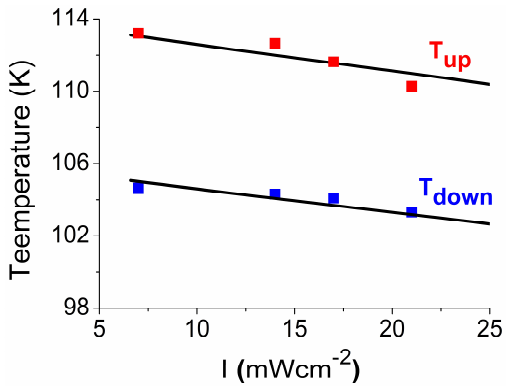
Figure 6. The dependence of the apparent switching temperatures upon the shining intensity, derived from Figure 5. The specific shining intensities were measured at the location of the sample cell.